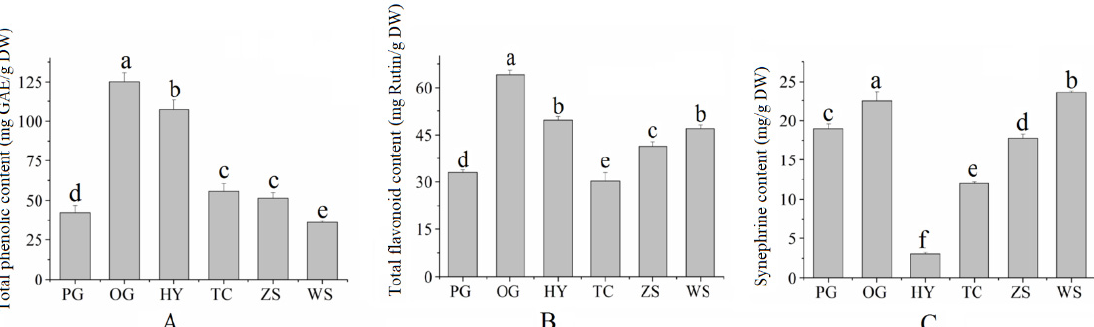
Figure 1. Total phenolic ( A ), total flavonoid ( B ) and synephrine content ( C ) in young citrus (PG: Ponkan; OG: Ougan; HY;Huyou; TC: Tiancheng; ZS: Zaoshuwenzhoumigan; WS: Wanshuwenzhoumigan; Different letter represent the significant difference at p < 0.05 level ).